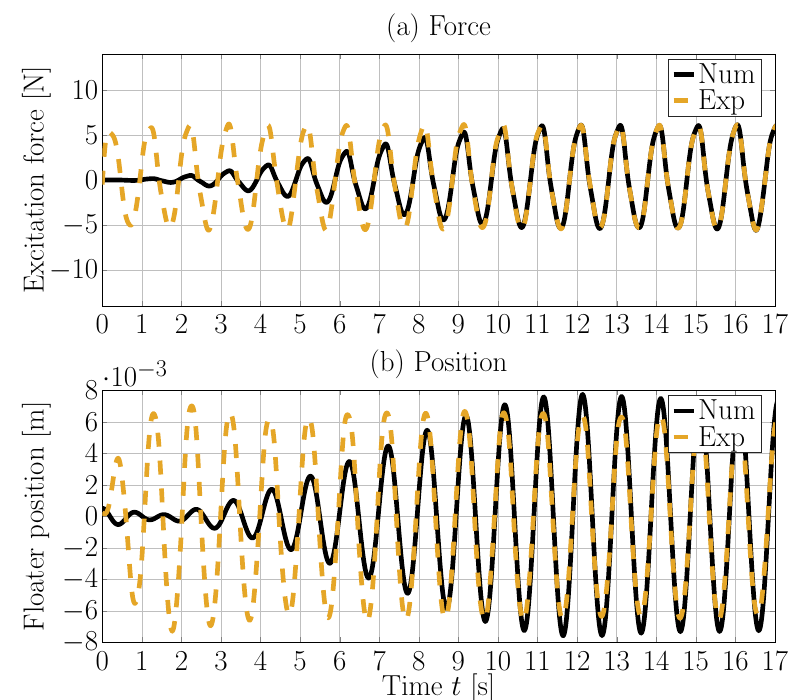
Figure 18. Time trace of the single-frequency (1.01 Hz) excitation force ( a ) and the floater position ( b